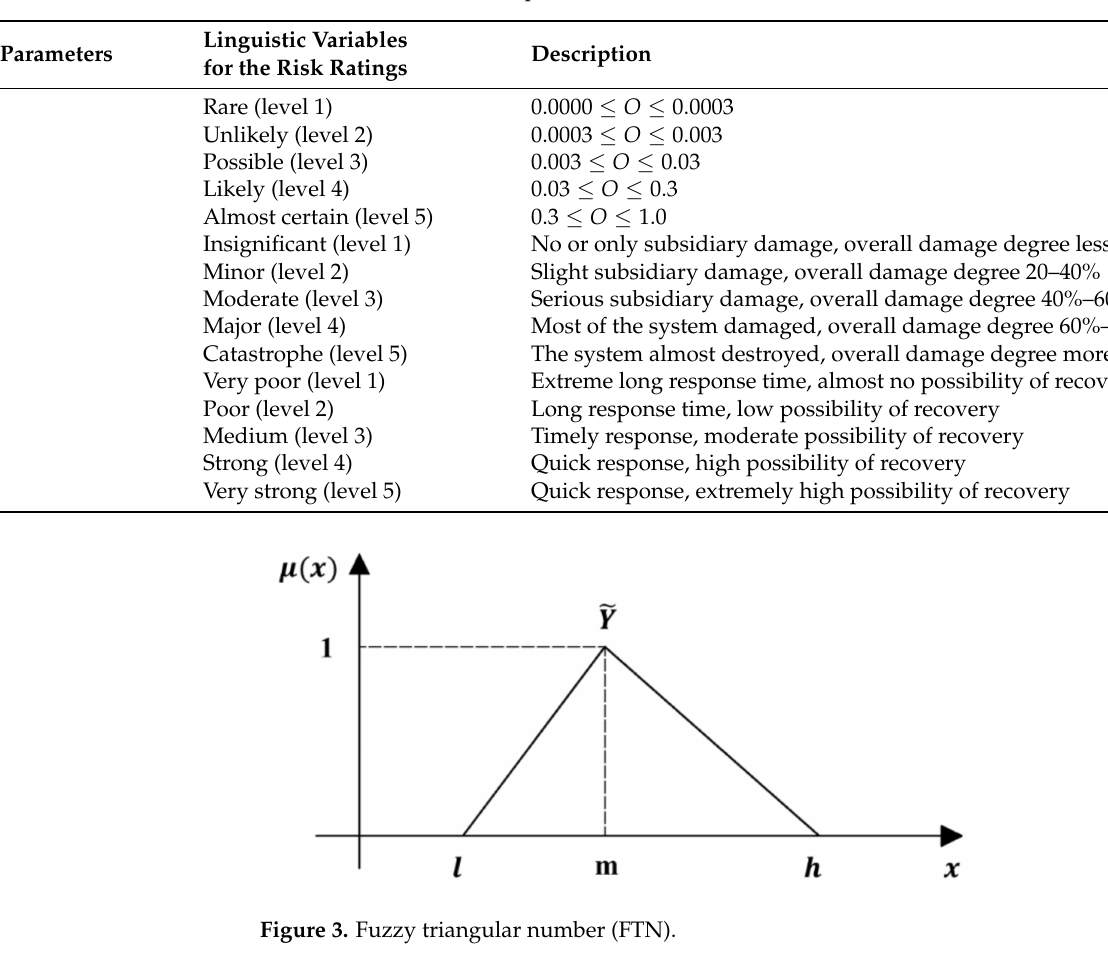
Table 1. Risk parameters’ classification.